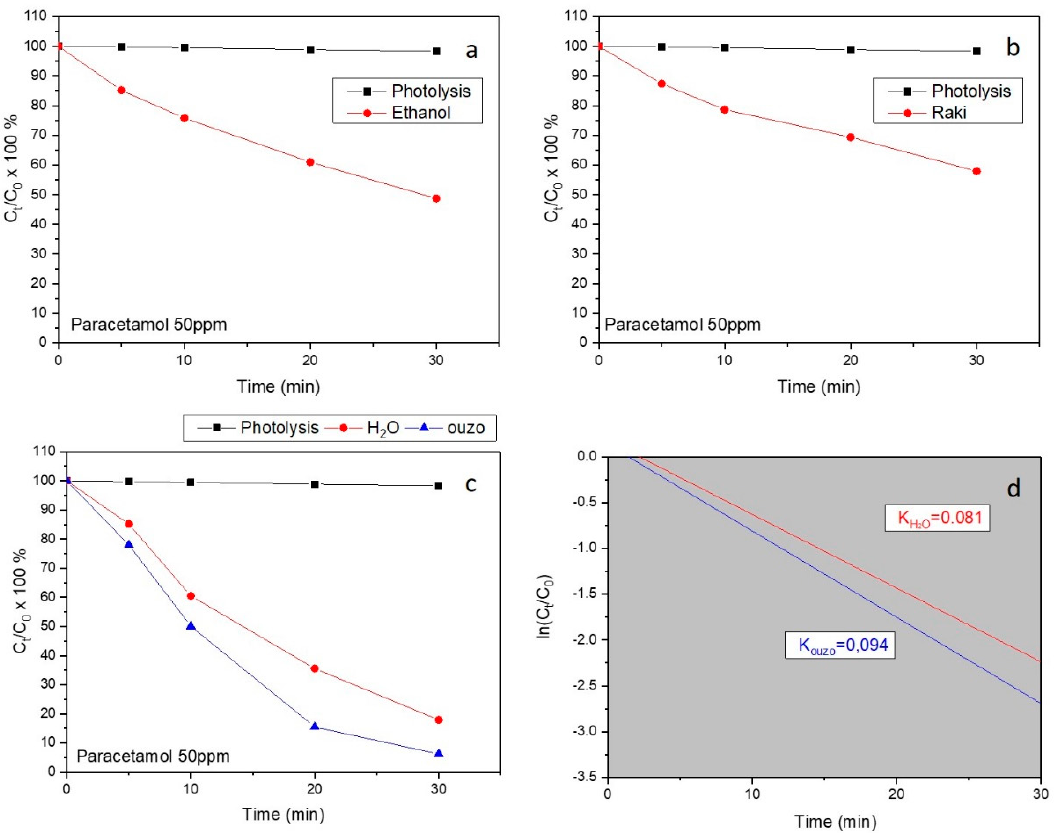
Figure 7. The percentage of paracetamol decomposition over the ZnO-based 3D-printed samples synthesized with eco- friendly solvents under UV-A irradiation, vs. irradiation time. ( a ) Ethanol. ( b ) Raki. ( c ) Two different solvents are presented H 2 O and ouzo (red solid circles and blue solid triangles, respectively). ( d ) The apparent rate constants (k) for water and ouzo cases. For comparison reasons, the photolysis curve (black solid squares) is also presented.